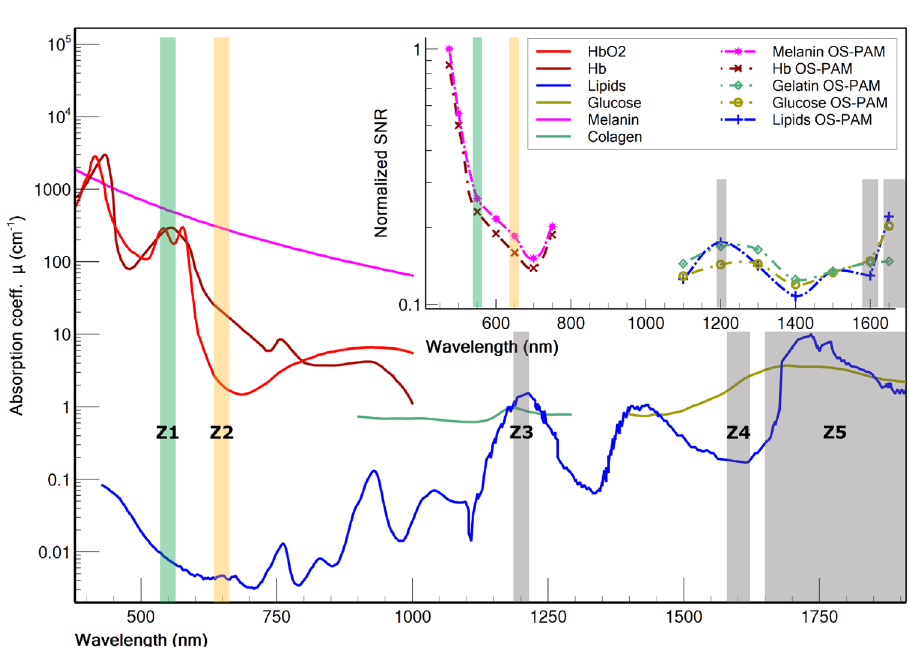
Figure 1. Graphs of the absorption coefficient for the most common endogenous contrast agents in tissue. Data for HBO2, Hb and Melanin were compiled from 31 , data for Collagen from 32 , data for Glucose from 24 , whereas data for lipids from 33 . The spectral windows used for OS-PAM imaging are highlighted in colours. Z1–Z5 represent the spectral zones used for mapping the contrast agents. Inset data is obtained performing in vitro OS-PAM